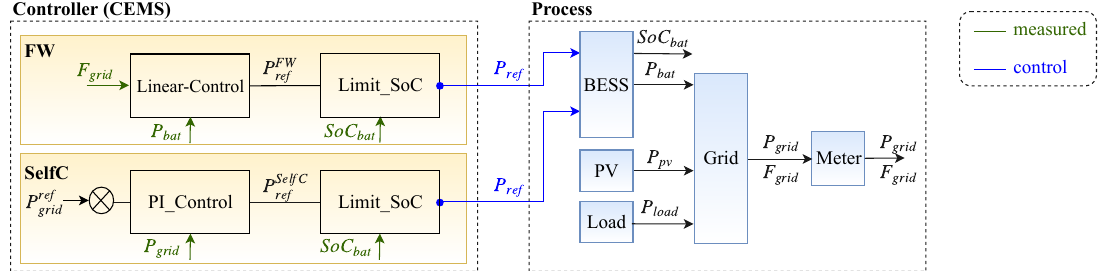
Figure 8. CEMS structure, systems and